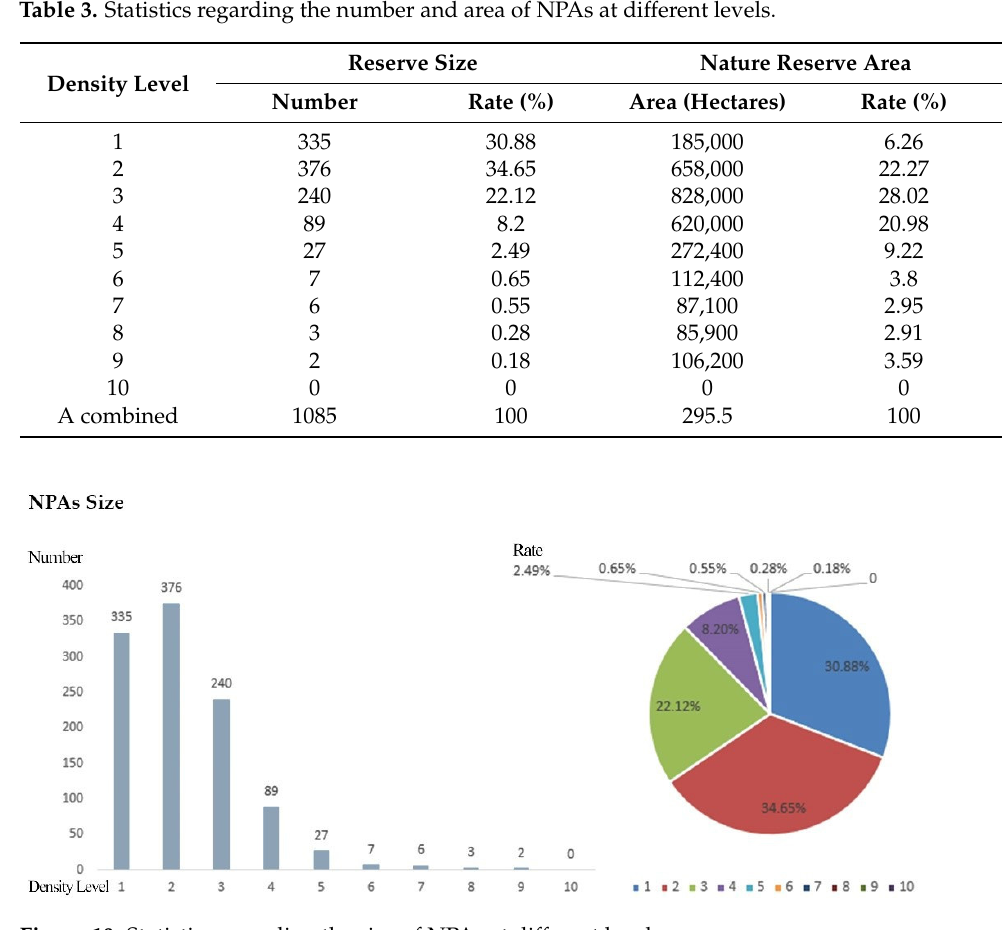
Figure 10. Statistics regarding the size of NPAs at different levels.